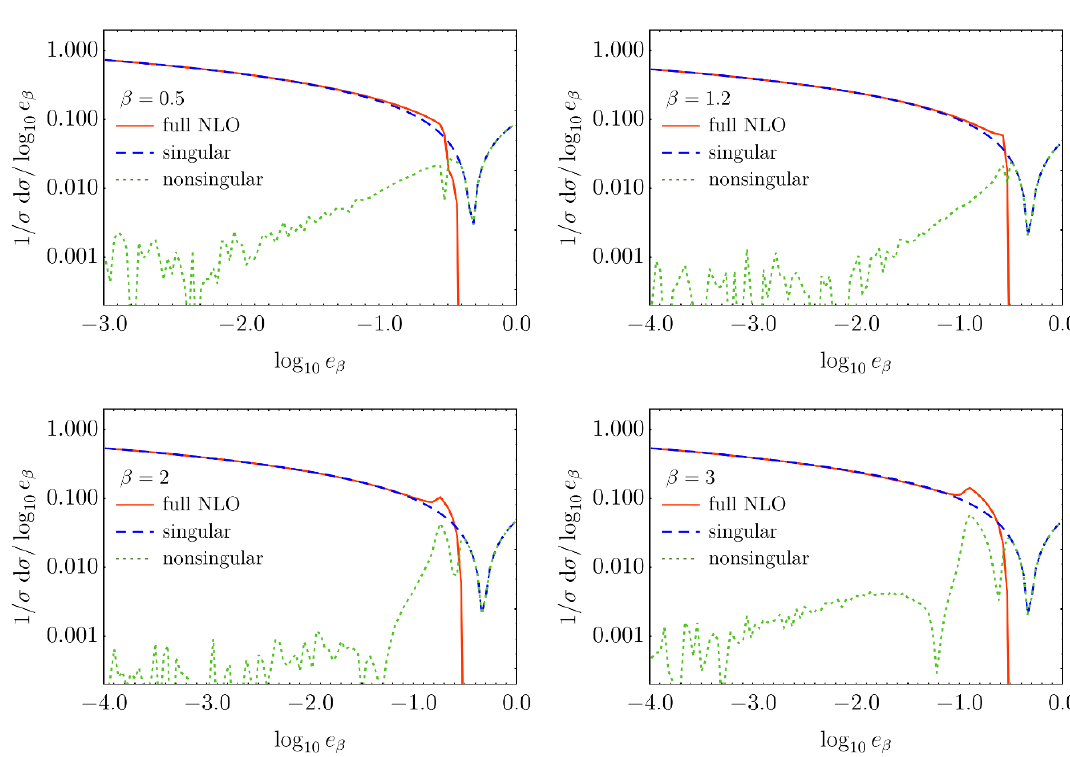
Figure 2 . The full NLO (red solid), the NLO singular (blue dashed) and nonsingular (green dotted) cross sections, for four angularities (cid:12) = 0 : 5 ; 1 : 2 ; 2 and